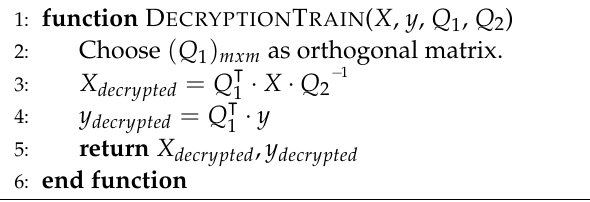
Algorithm 2 Decryption of Train Data